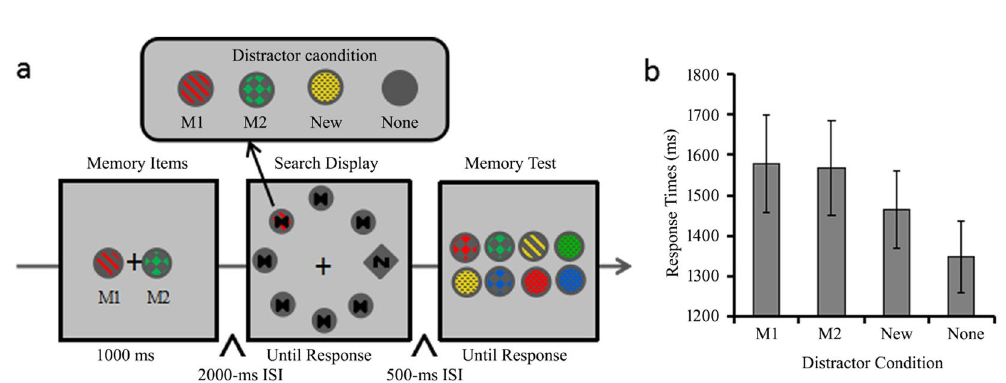
Figure 3. Trial sequences and results for Experiment 3. ( a ) The sequence of events with four possible distractor conditions in a trial (M1, M2, New and None distractor condition were the same as the two memory items condition in Exp 2). ( b ) RTs for the search task as a function of distractor condition. Error bars indicate ± 1